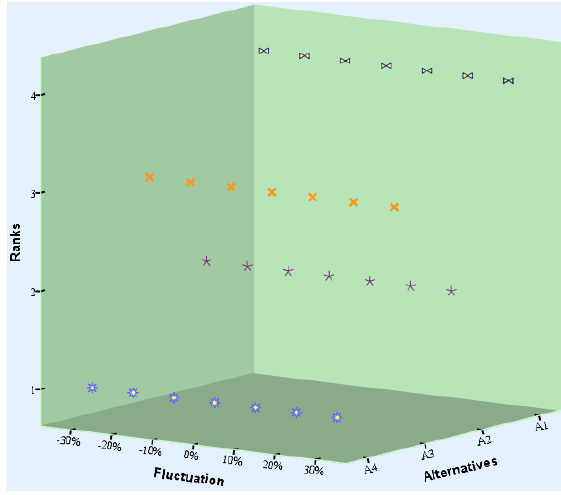
Figure 3. The sensitivity analysis results. represent the ranks of alternatives A1, A2,